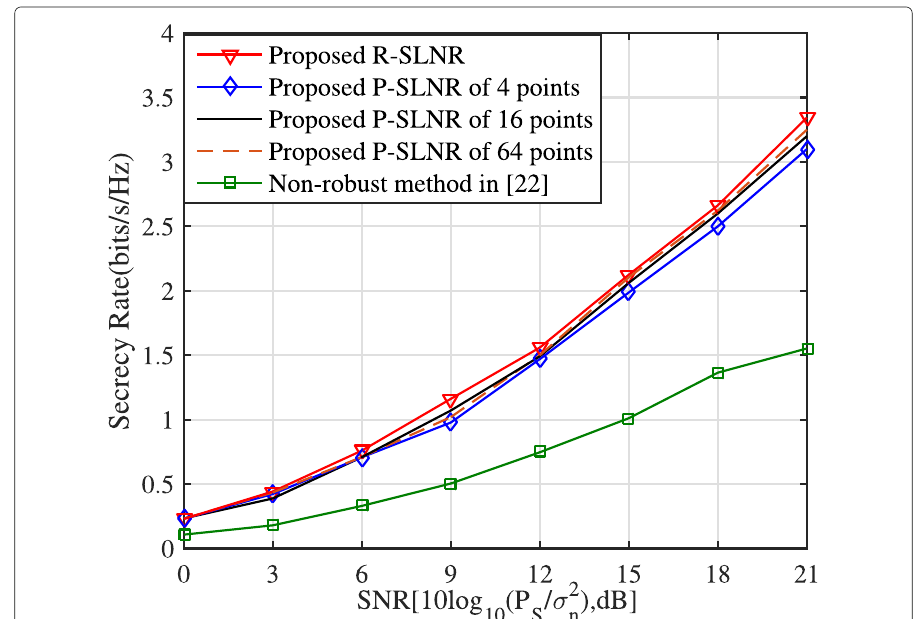
Fig. 5 Secrecy rate versus SNR(10 log 10 ( P /σ 2 n ) ) of the proposed methods with N T = 16, B = 5 MHz , = 6 ◦ , and (cid:7) r = 50 m (cid:7)θ max max